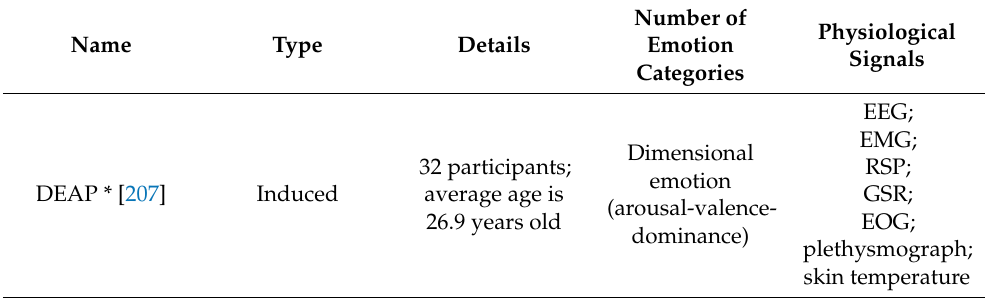
Table 5. Datasets of physiological